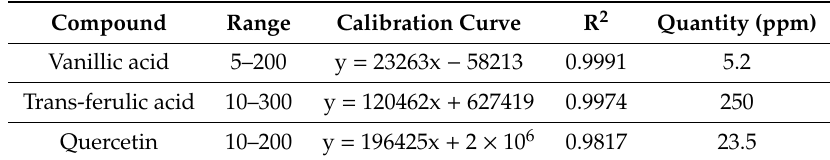
Table 2. Calibration curves for marker compounds at concentrations ranging from 5 to 300 ( µ g / mL). R 2 represents the goodness of the